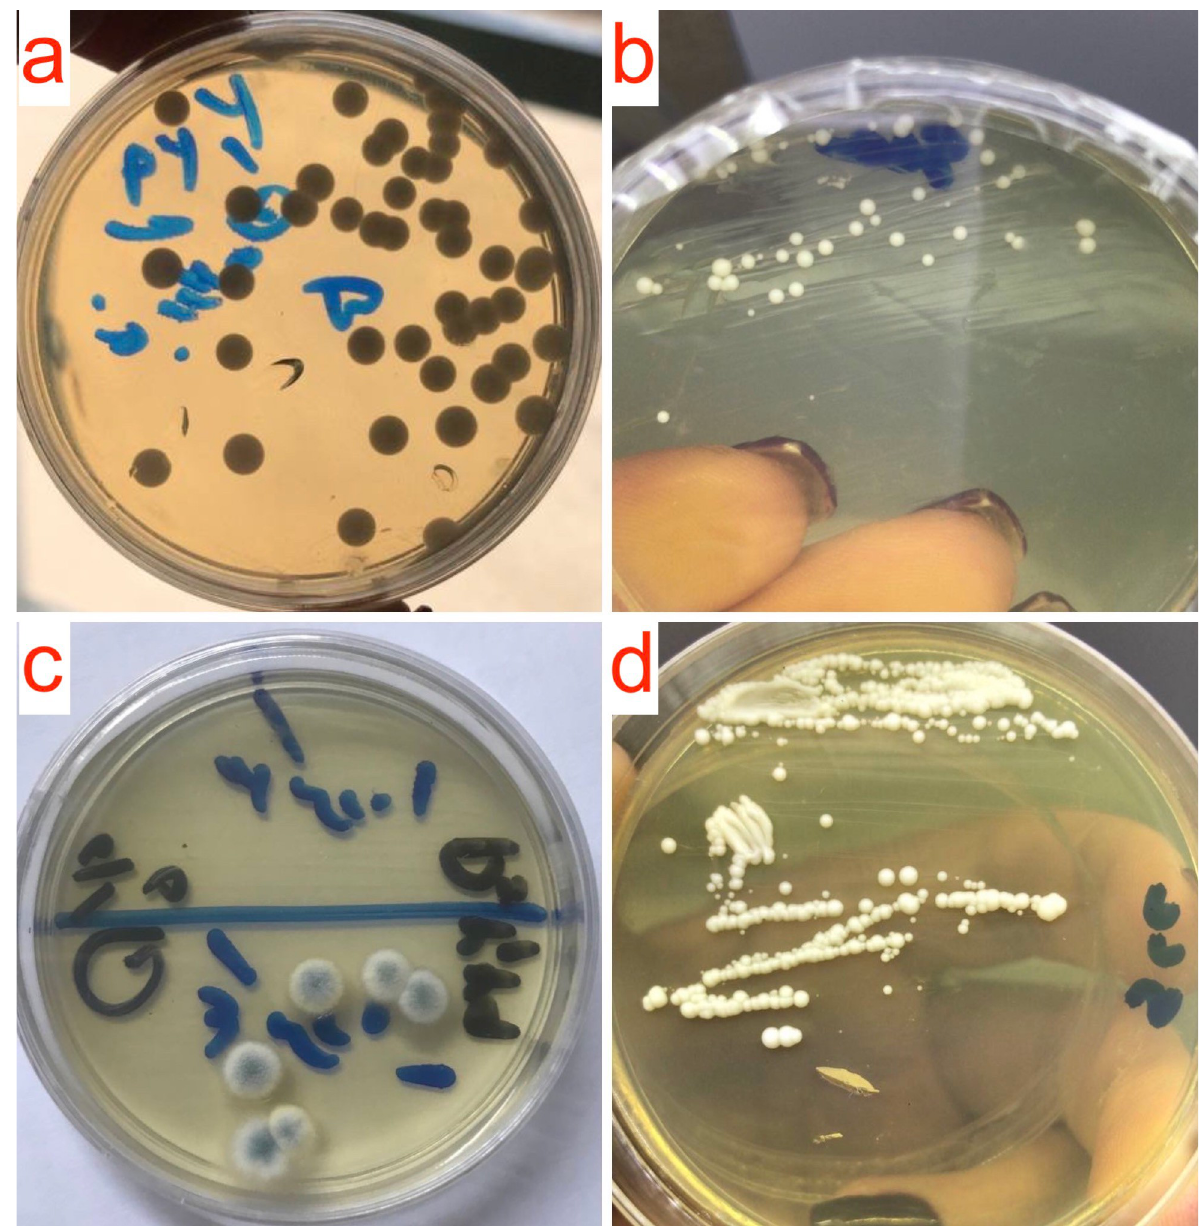
Fig 5. Final results of four selected mice’s organ cultures. First, the mice’s organs were extracted and prepared through sterile procedures and spread on SDA plates. Then, the plates were incubated for 30 hours in 37˚C, after which, the colonies were counted, the results were documented and the depicted photographs were taken. It should be noted that the photographs were taken after completion of the experiments and documentation of their results, and that during the experiments, none of the microbiological Petri dishes were handled without gloves as seen in these photographs. (a) Vaginal sample from a mouse in arm 5; (b) Liver sample from a mouse in arm 6; (c) Vaginal sample from a mouse in arm 2 (above) and a mouse in arm 3 (below); (d) Kidney sample from a mouse in arm 3. Abbreviations: SDA, Sabouraud dextrose agar.